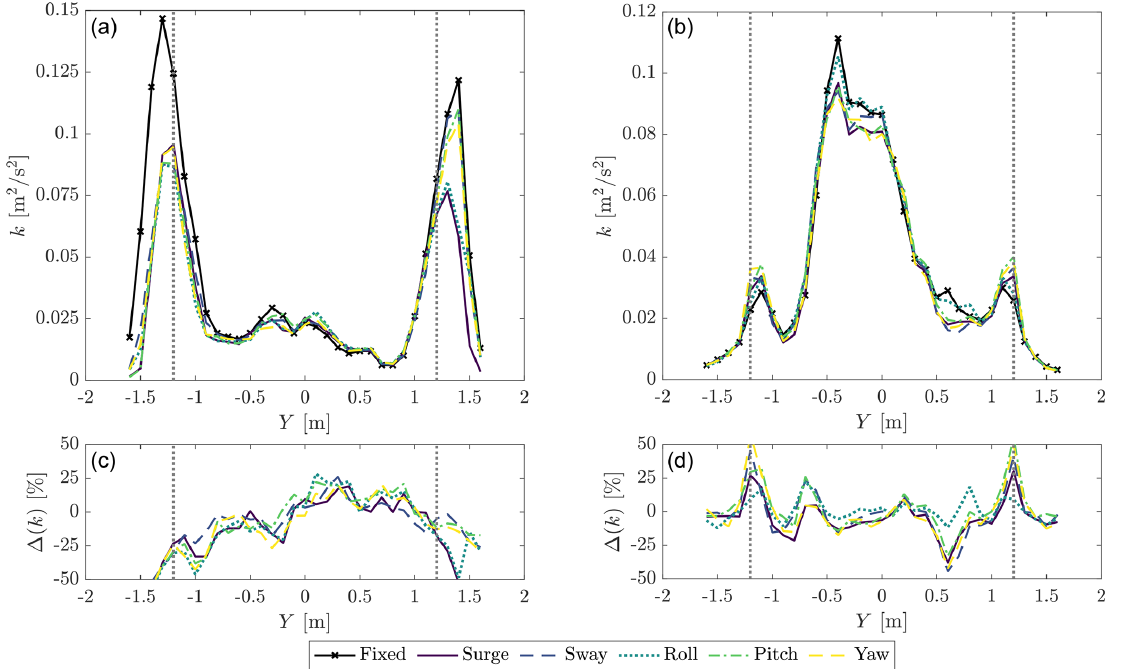
Figure 8. Turbulence kinetic energy at X = 2 . 3 D for the fixed case and with different motions at the wave frequency, in WC1 (a) and WC2 (b) . (cid:49) ( k ) is the turbulence kinetic energy increment with motion with respect to the fixed case (WC1: c ; WC2: d ). The vertical dotted lines mark the edge of the